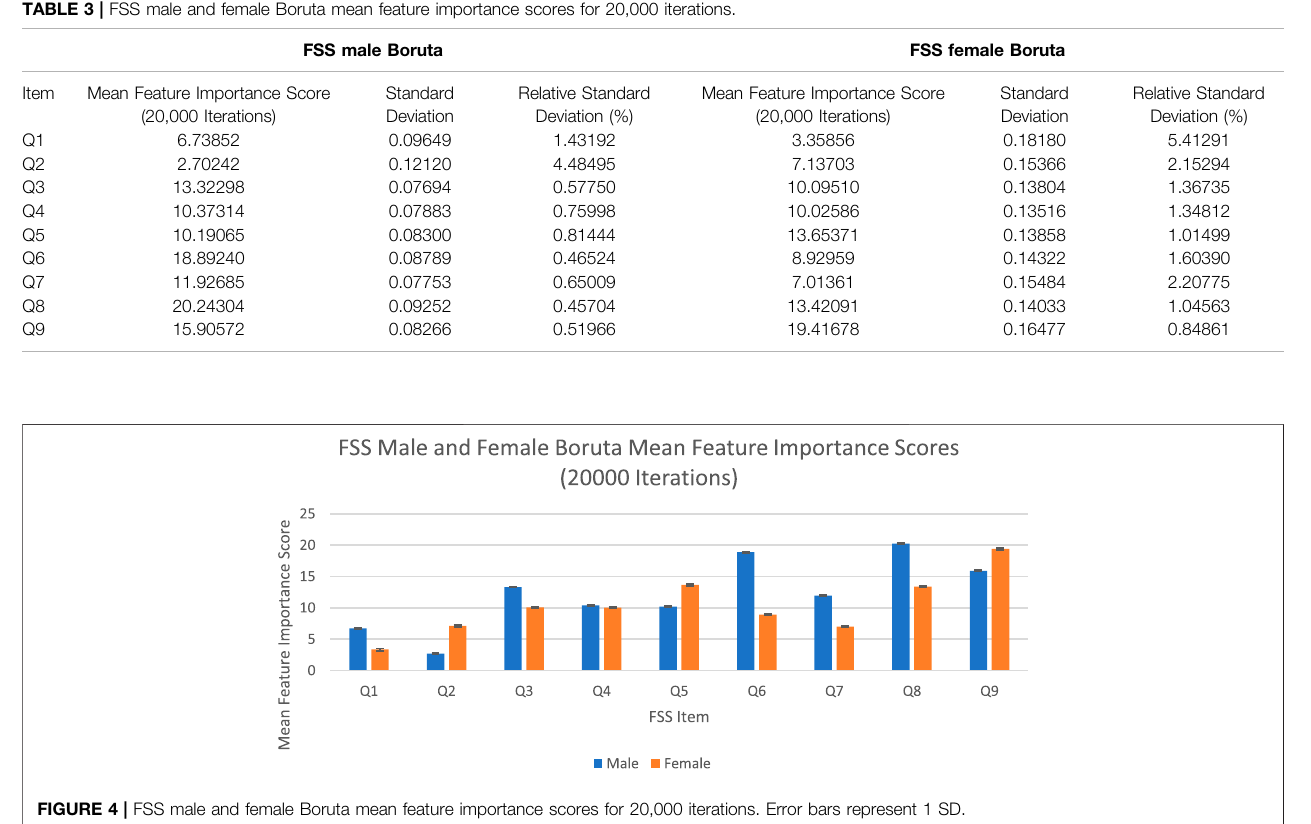
Frontiers in Arti fi cial Intelligence |